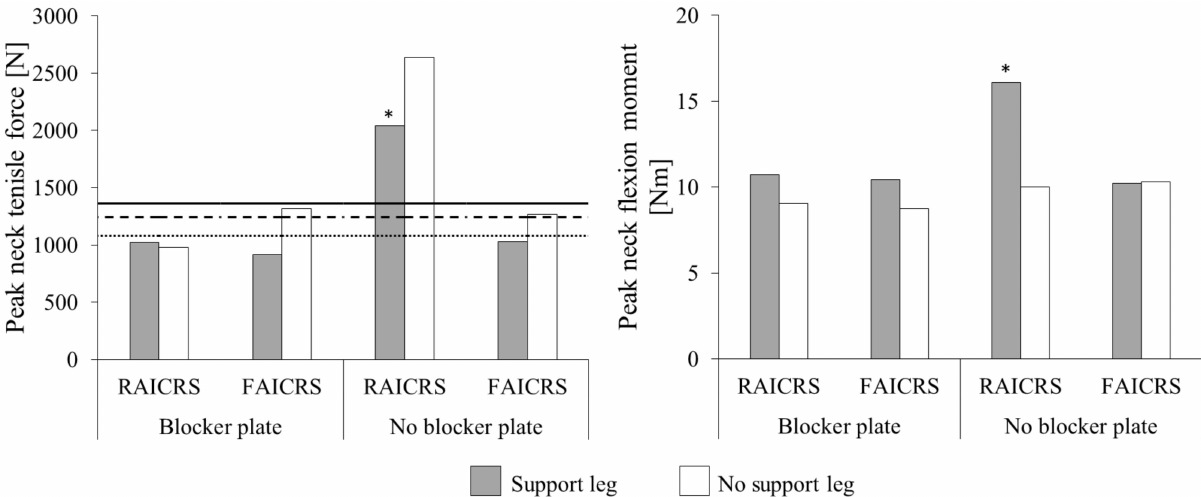
Figure 3. Head and neck injury metrics for the Q1.5 ATD in rearward-facing CRS models during frontal impacts with (shaded bars) and without (unshaded bars) a support leg. Q1.5 ATD head injury tolerance values (dotted lines) scaled from UN ECE R94 and 20% (dashed lines) and 50% (solid lines) risk of AIS3+ head injury tolerance values from Wismans et al. [17]. Note that there is no tolerance value scaled from UN ECE R94 for HIC 15 and injury tolerance values for peak neck flexion moment are beyond the scale of the axis. Impact data for tests with the blocker plate were previously reported by Patton et al. [9]. RAICRS: rigid anchor infant child restraint system. FAICRS: flexible anchor infant child restraint system. * Denotes the impact test in which the support leg partially collapsed during the